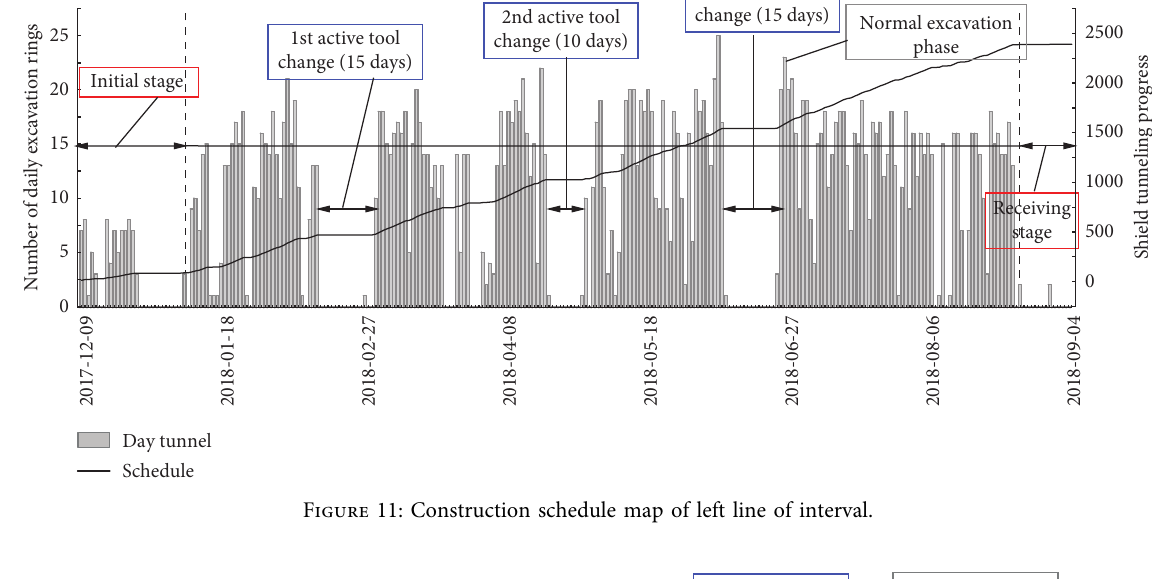
Figure 11: Construction schedule map of left line of